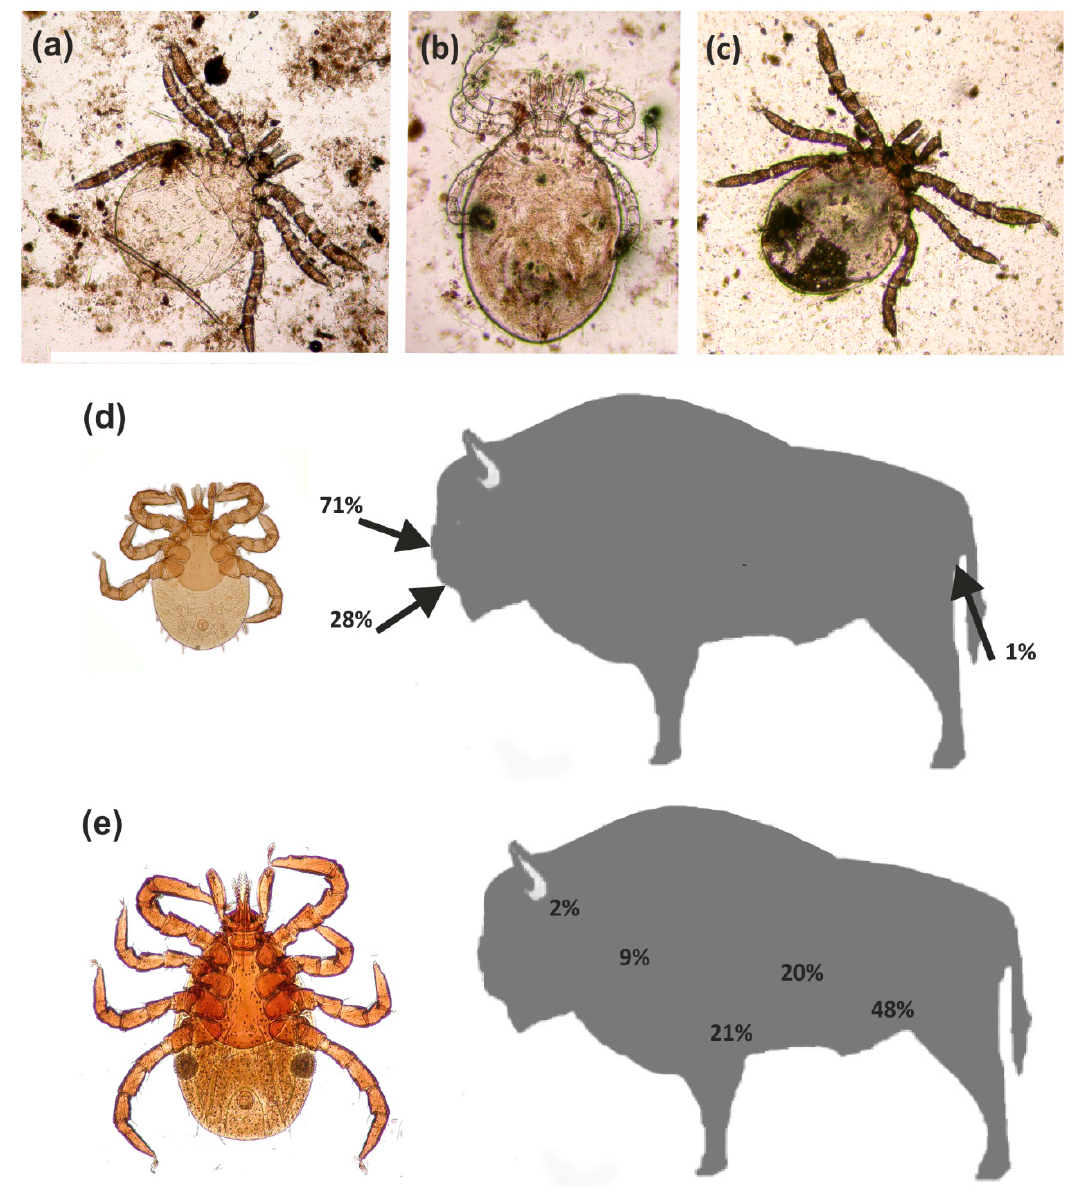
Figure 4. Ixodes ricinus : ( a – c ) Larvae from the nasal cavity; ( d ) Topography of larvae in the European bison; ( e ) Topography of females in the European bison.